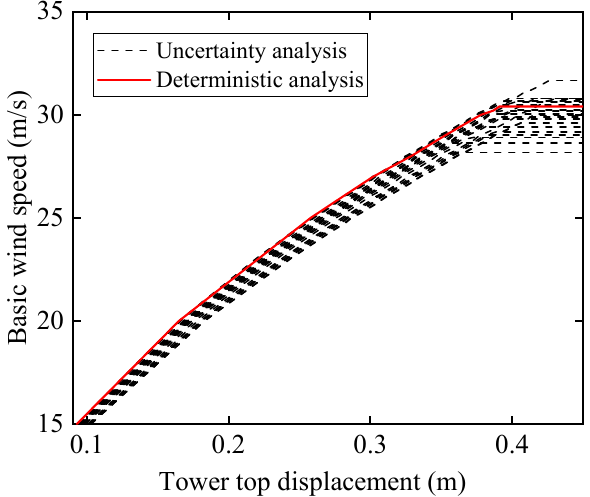
Figure 10. Pushover curves for transmission tower models.